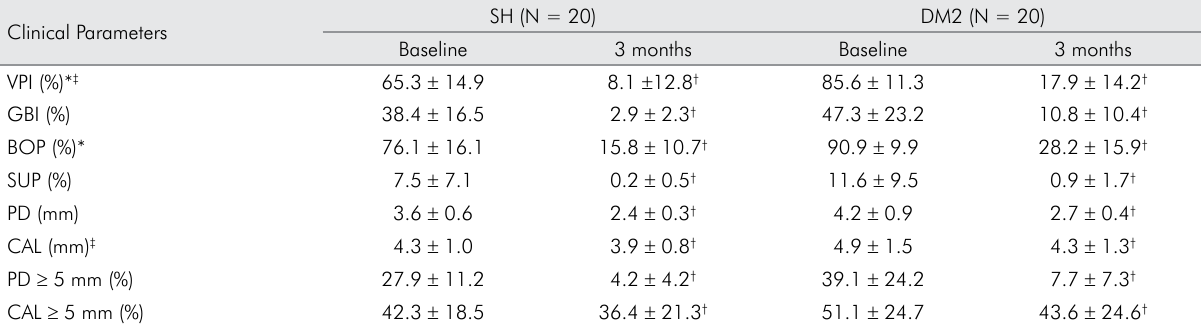
Table 1. Mean ( ± SD) of the periodontal clinical parameters for the control (SH) and diabetes (DM2) groups at baseline and 3 months after